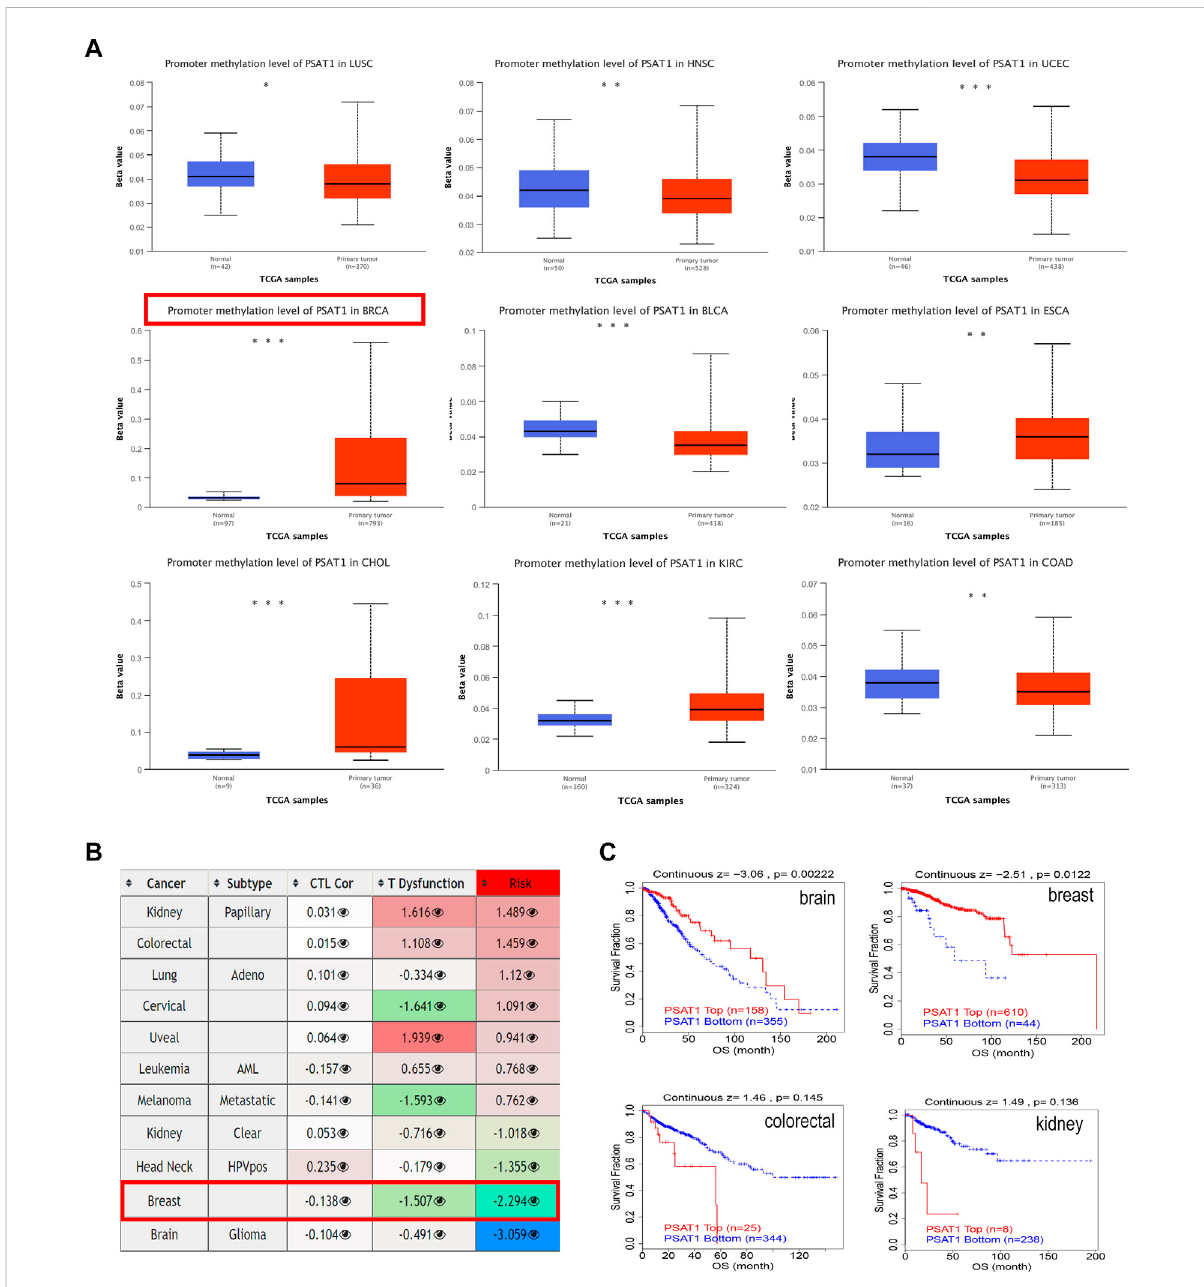
FIGURE 4 The methylation levels of PSAT1 in cancers and poor prognosis of cancer cohorts. (A) The methylation levels of PSAT1 between cancer and adjacent normal tissuesthroughTCGAdatabase.* p < 0.05;** p < 0.01; *** p < 0.001 (B) Heatmapshowingtherole ofPSAT1methylation incytotoxic T-cell levels (CTLs), dysfunctional T-cell phenotype, and risk factors of TCGA cancer cohorts (C) Analyzing the difference in overall survival between PSAT1 hypermethylated and hypomethylated in various tumors through the TCGA